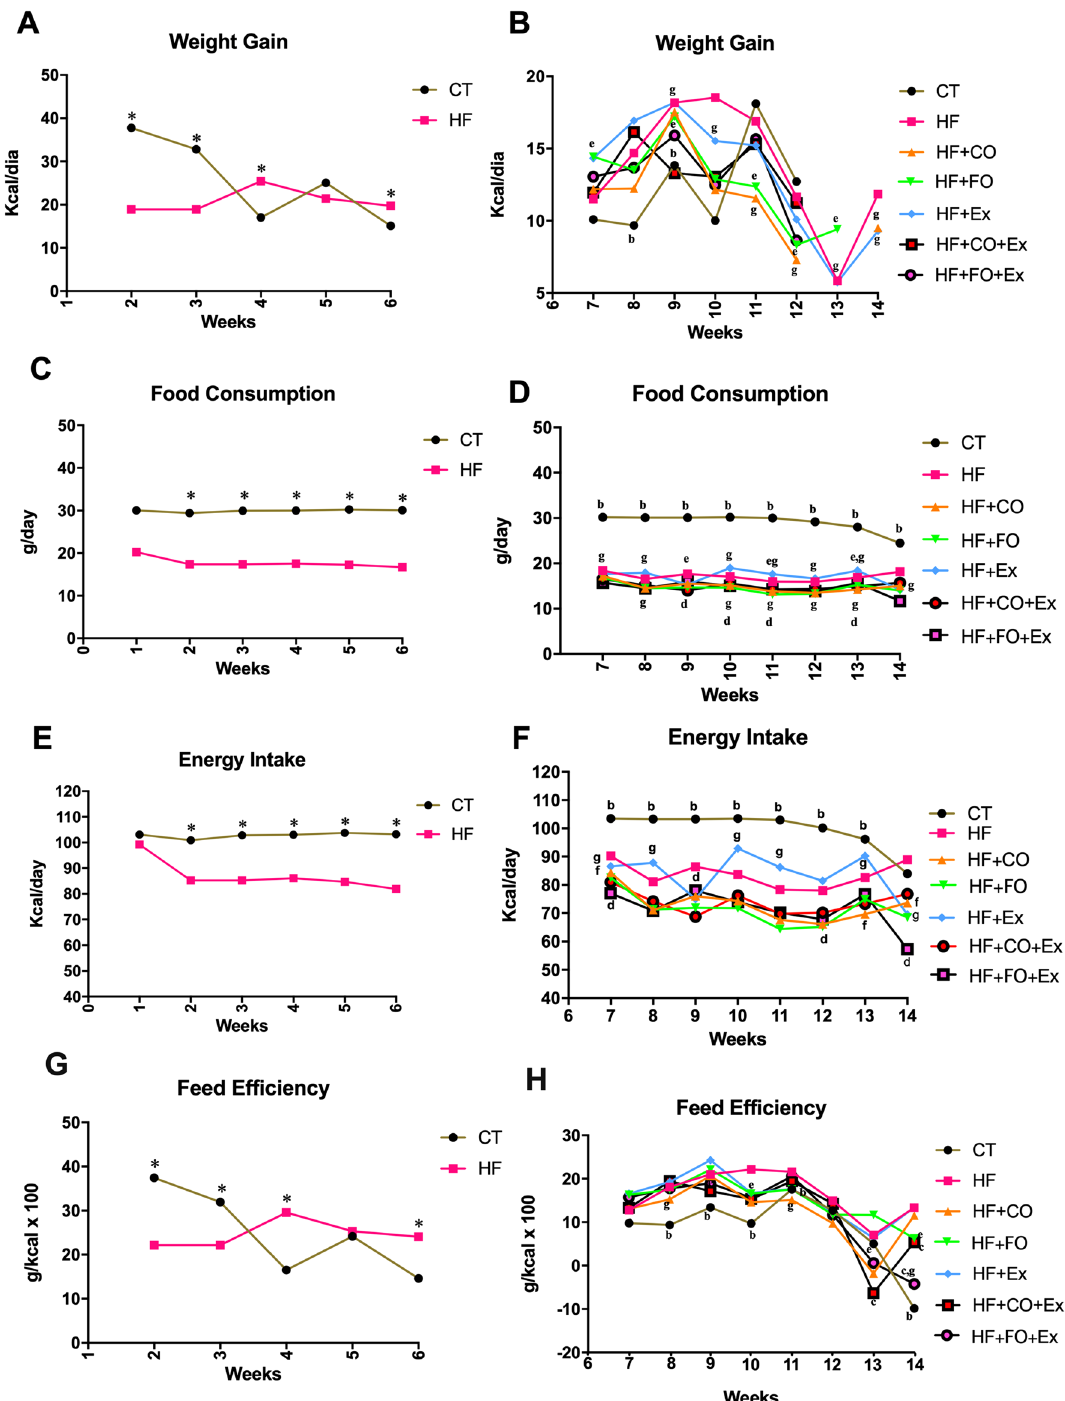
Figure 1. Nutritional data of weight gain, food consumption, energy intake and feed efficiency of the animals for the 14-week